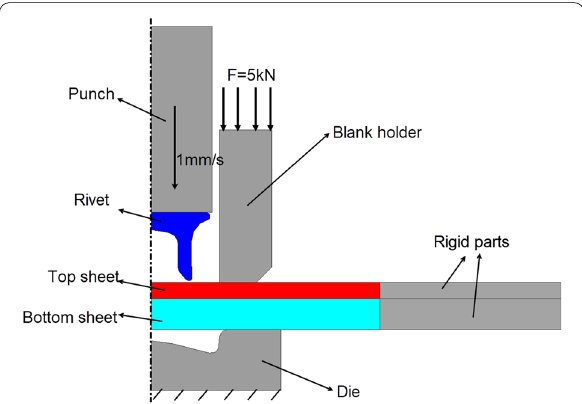
Figure 3 Boundary condition of SPR process